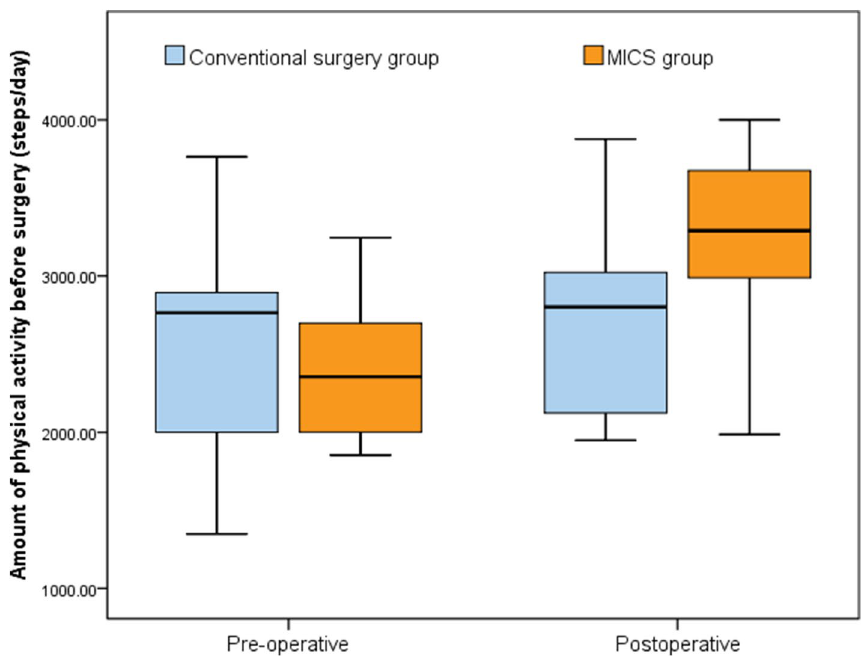
Fig. 1 The amount of physical activity before and after surgery measured by triaxial accelerometer (steps/